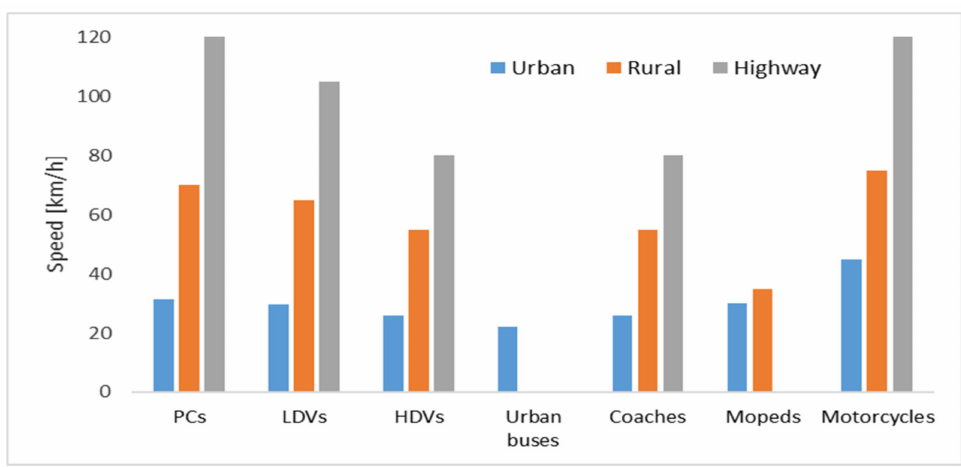
Figure 2. Vehicle speed for each road class in 2020 in Poland